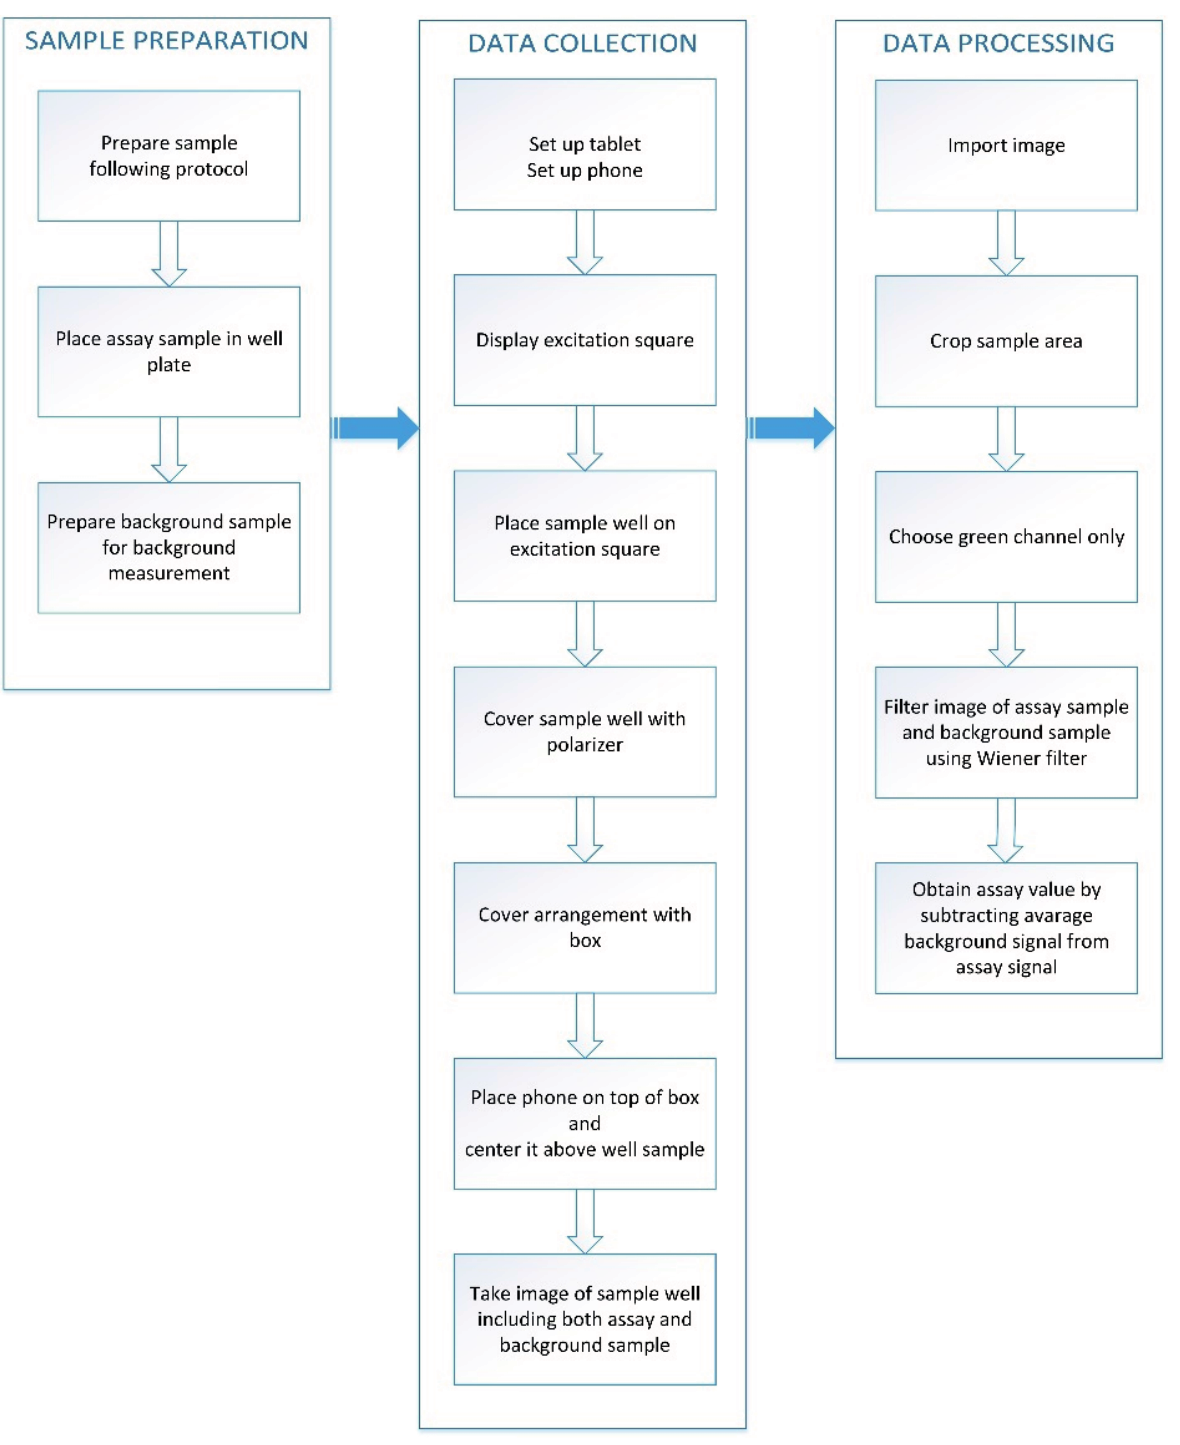
Figure 3. The assay